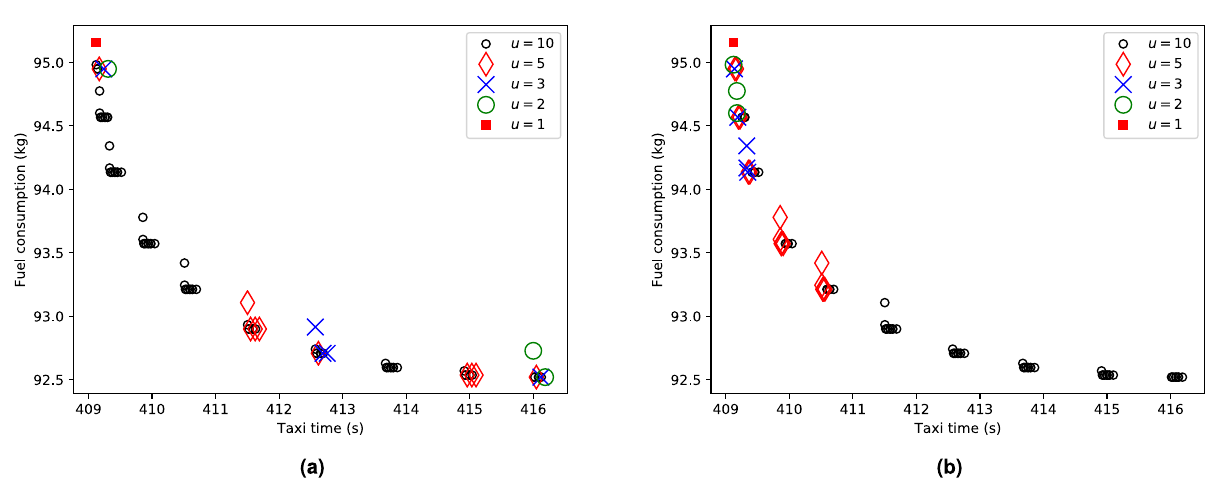
Figure 4. Pareto front for a single aircraft: ( a ) solutions obtained by AMOA* with multi-graph reduction based on evenly distributed solutions and increasing u , ( b ) solutions obtained by AMOA* with preferences with w p = ( M , 0 ) , where M is a large number and increasing u